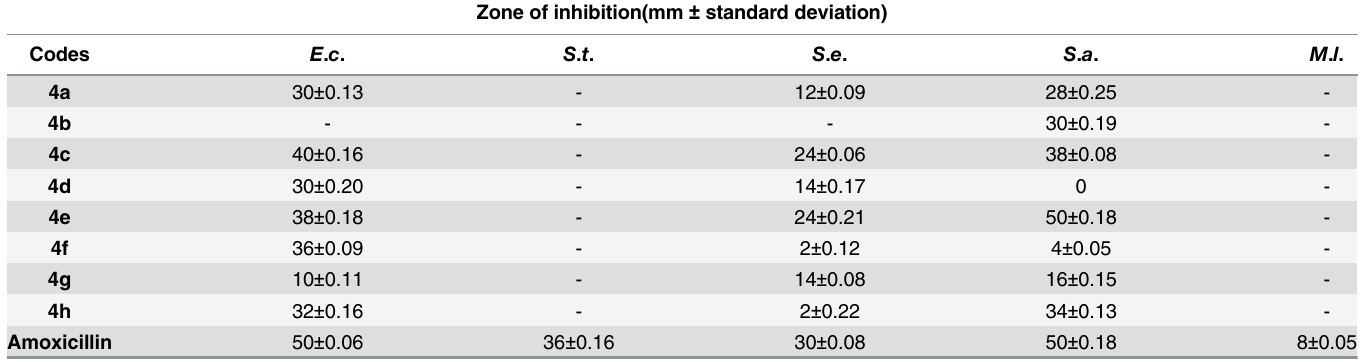
Table 1. Antibacterial activity result of penicillin derivatives